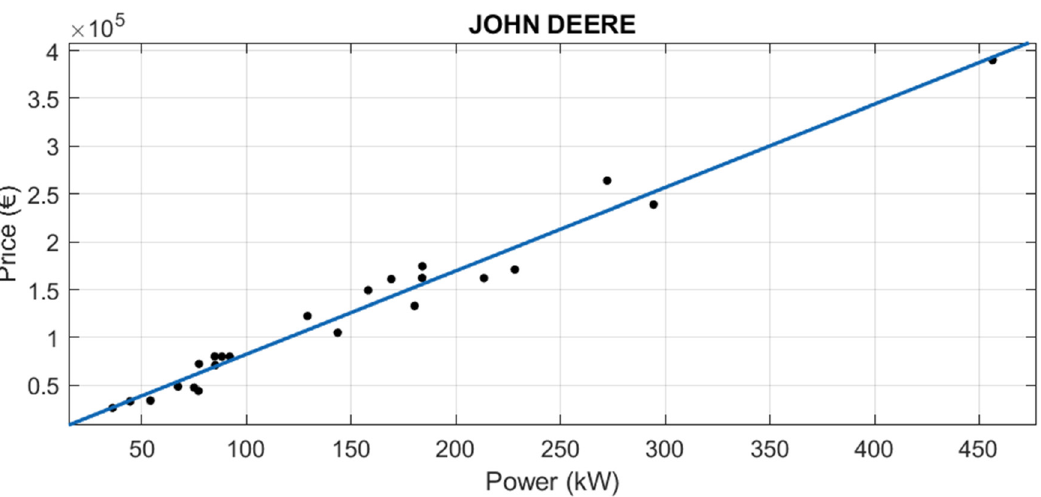
Figure 7. Price vs. power for Iseki new tractors.